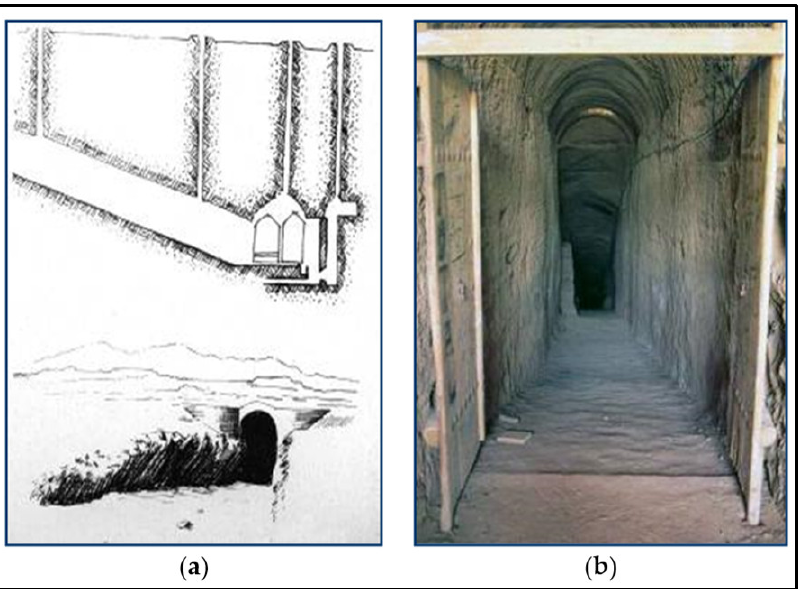
Figure 9. The water mill of Mohammad Abbad in Meybod: ( a ) sketch of a double stone mill and ( b ) its entrance (adapted from [32]).